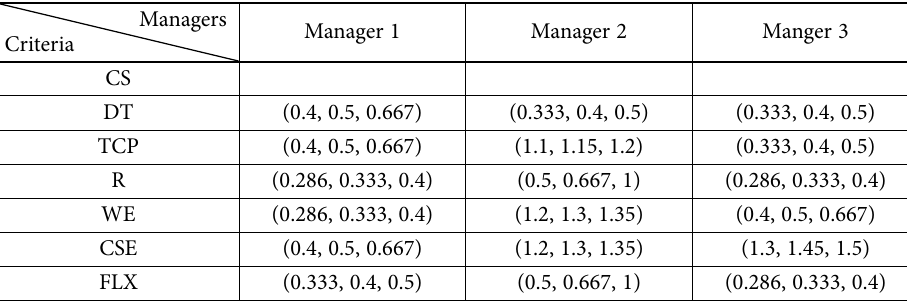
Table 4. The fuzzy PIPRECIA